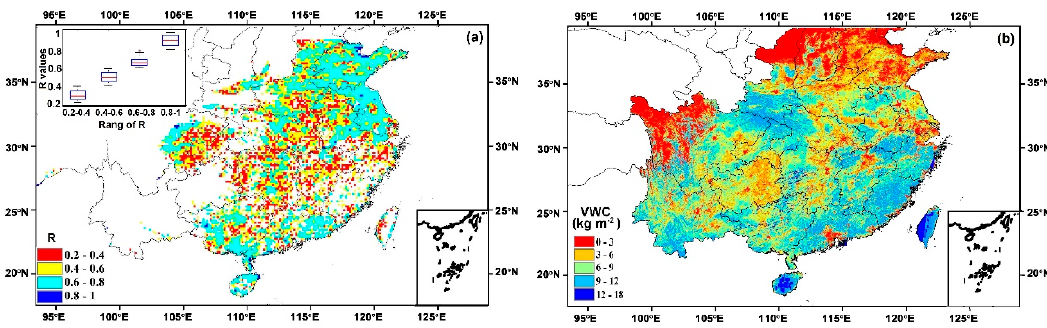
Figure 4. ( a ) R between daily averaged CYGNSS SR and SMAP SM, ( b ) the averaged VWC estimated from NDVI with empirical relations over the observed time